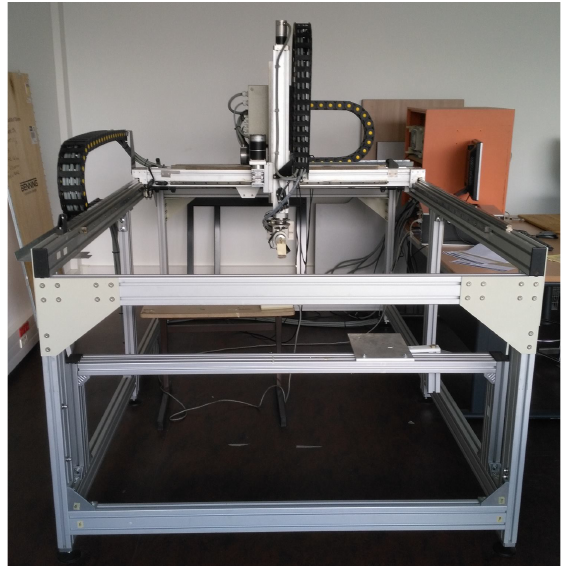
Figure 1. Near field robot used in our static experiments. The probe can move within 2 × 1.5 × 1 m 3 , 10 µm positioning